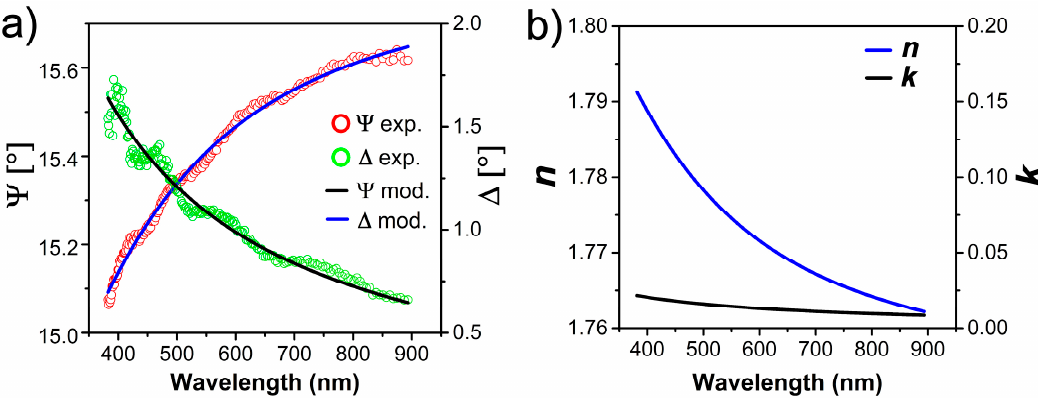
Figure 2. ( a ) Experimental data and fit of the Ψ and Δ angles for the Al 2 O 3 substrate; ( b ) Cauchy-type model of infinitely thick Al 2 O 3 substrate. Model n and k are shown.